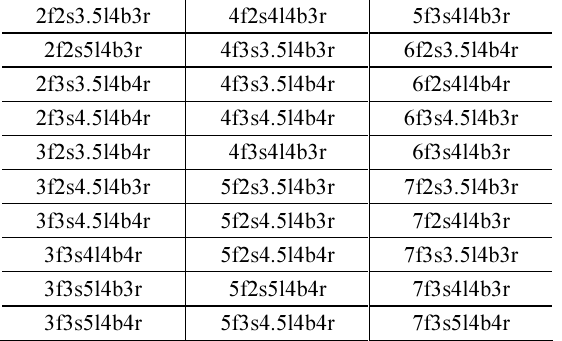
Table 1. Modelled structures for comparative study